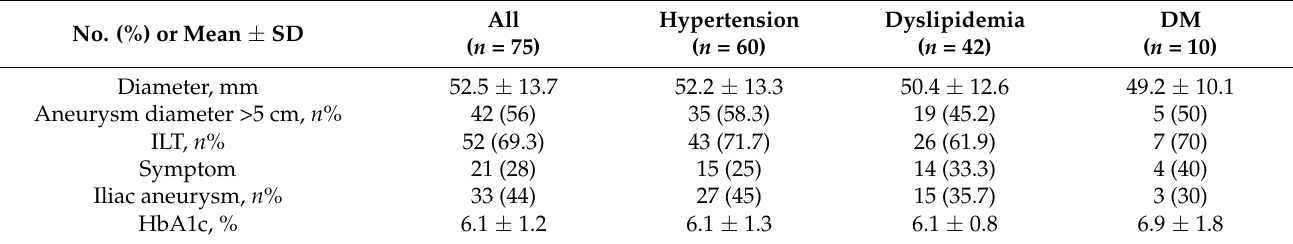
Table 2. Clinical characteristics for AAA